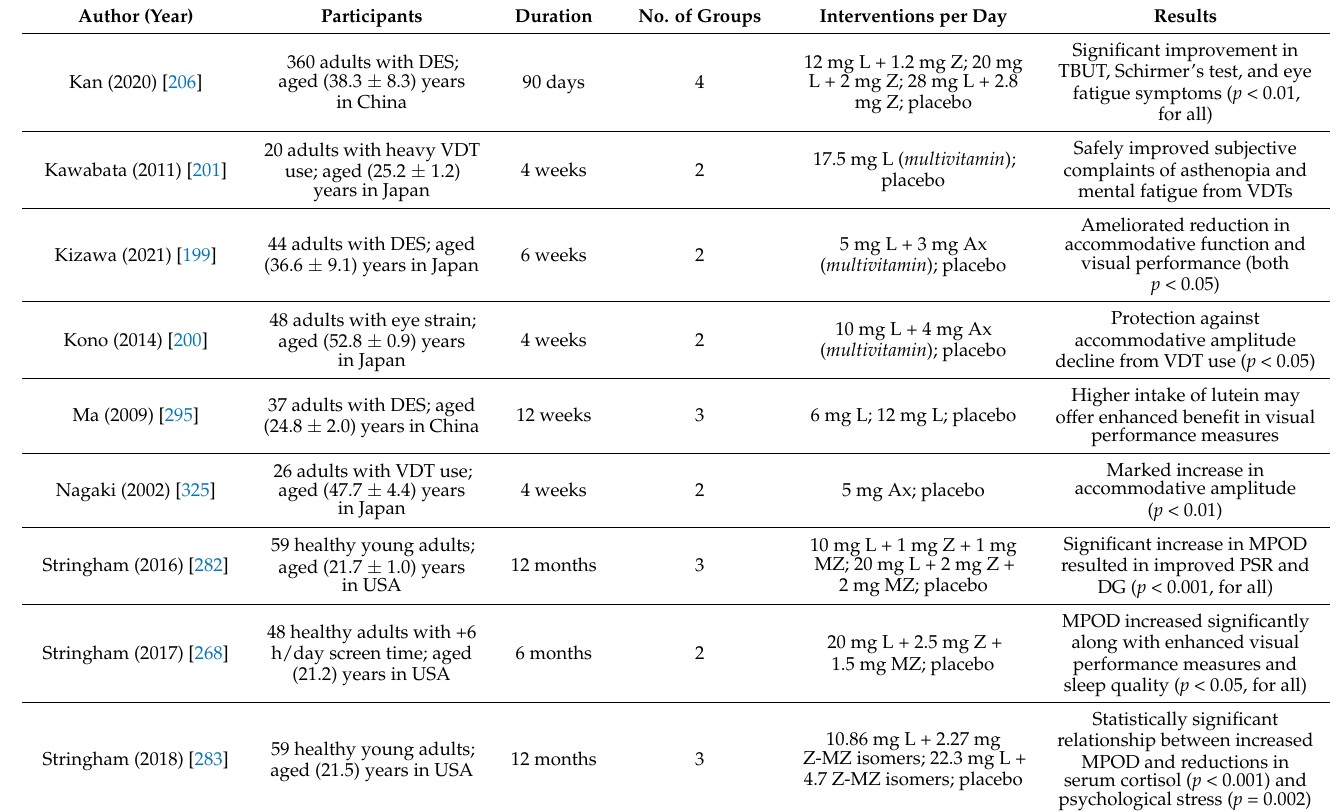
Table 3. Characteristics of the randomized clinical trials using